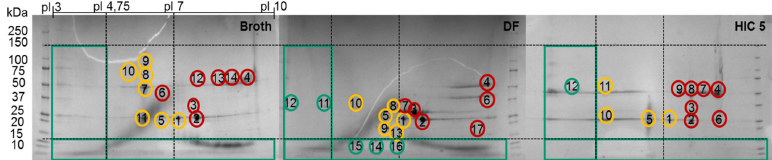
Figure 8. 2D SDS ‐ PAGE of the broth, diafiltrated broth (DF) and HIC fraction. Green circles represent “Good”, yellow circles “Bad,” and red circles “Ugly” HCP.